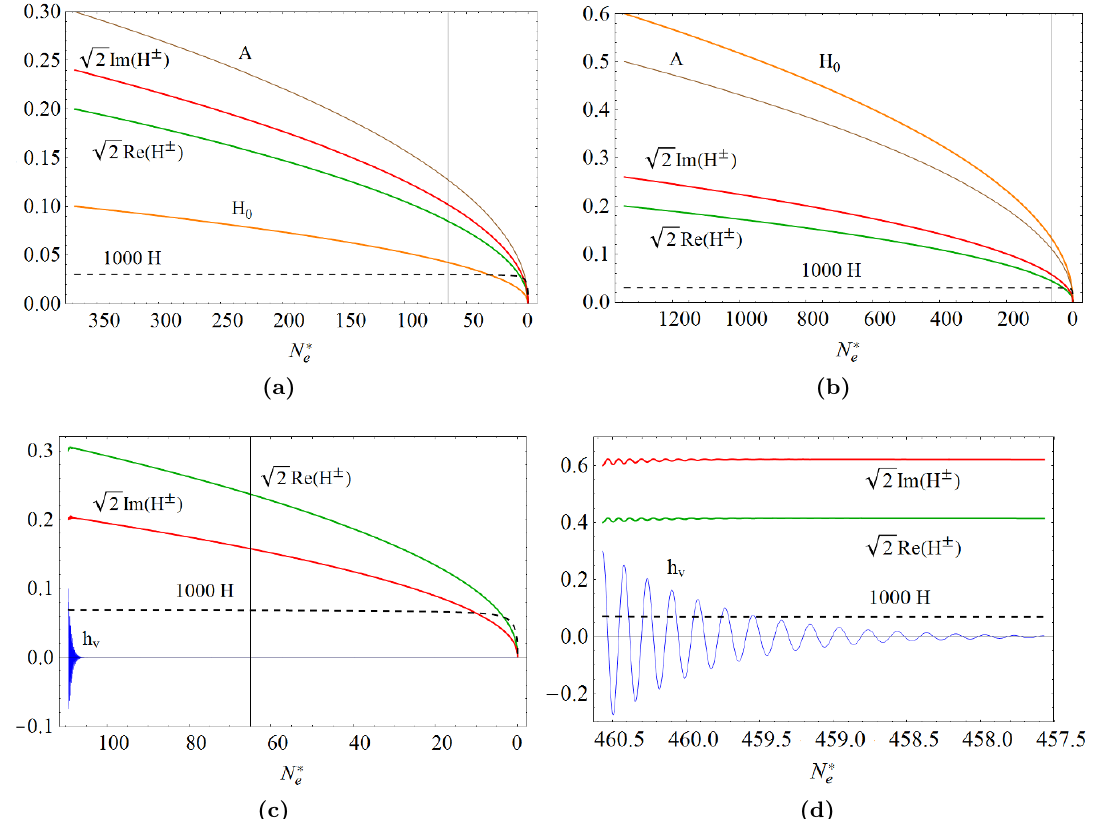
Figure 3. Evolution of the (cid:12)elds and the Hubble parameter (in units of M Pl ) as functions of the number of e-foldings before the end of in(cid:13)ation N (cid:3) for the scenarios A 1 (a), A 3 (b), B 1 (c) and B 2 e (d), see table 1. The thin vertical black line corresponds to the number of e-foldings N (cid:3) = 65. Plot e (d) for the B 2 scenario shows the evolution for smaller scale in the N (cid:3) interval from 460.5 to 457.5. e The evolution (d) for the entire N (cid:3) interval is similar to plot e